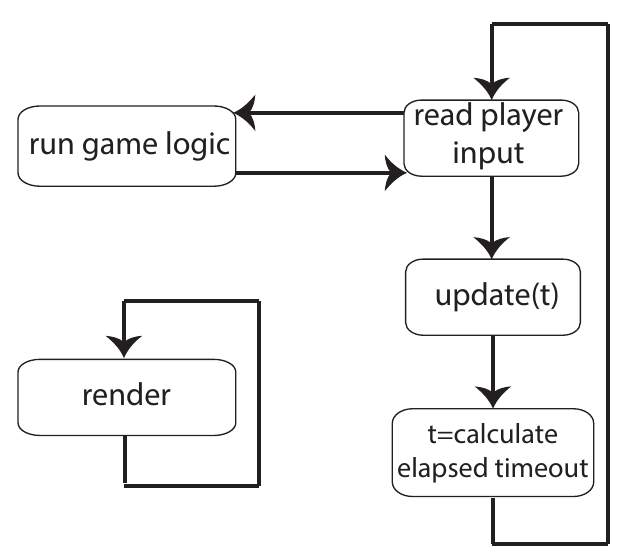
Figure 3. Fixed-Frequency Uncoupled